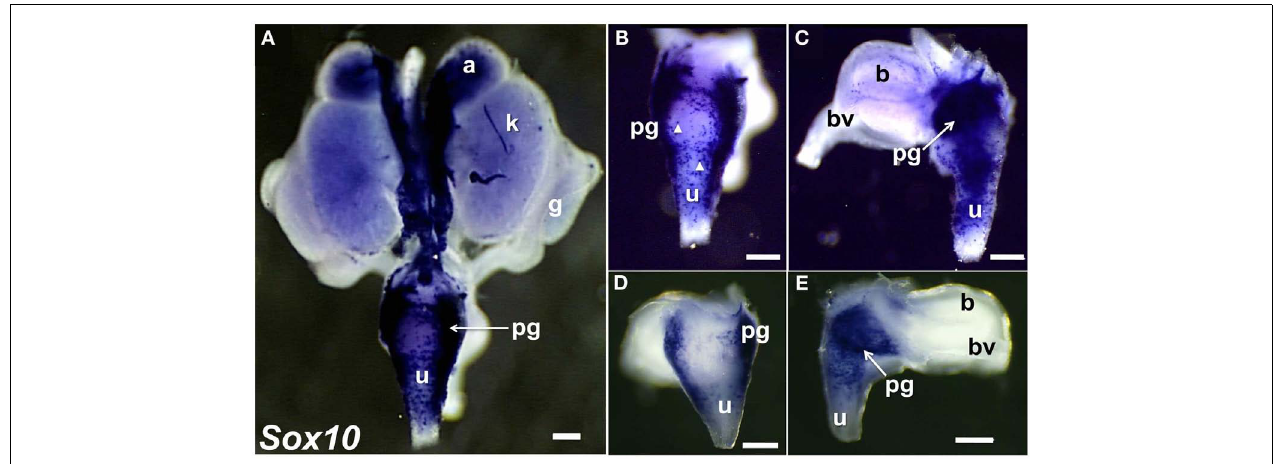
MGI:3506241, scale bar = 300 µ m). Images of 15.5dpc UGT samples developed for a shorter period of time to discriminate regions of high versus low Sox10 expression are shown (D,E) . Sox10 + progenitors are present in dorsal urethra [ (D) , 50 × ] and in pelvic ganglia viewed laterally (E) . Note the high intensity of Sox10 expression within the interior region of the pelvic ganglia (arrow). GUDMAP probe MTF511, MGI:3506241. Scale bar = 300 µ